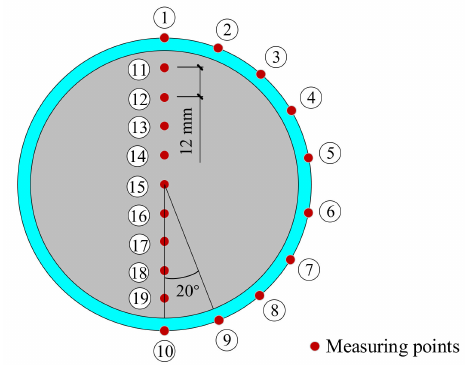
Figure 2. The arrangement of measured points on the mid-span sections.